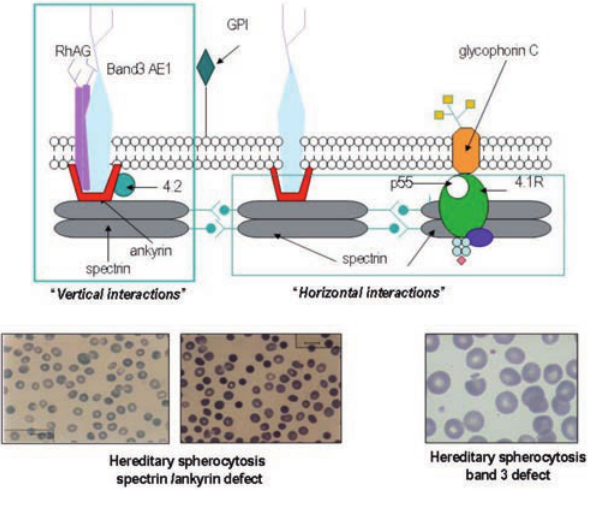
Figure 1. Schematical representation of RBC membrane struc- ture, vertical and horizontal interactions. RBC morphology in hereditary spherocytosis.